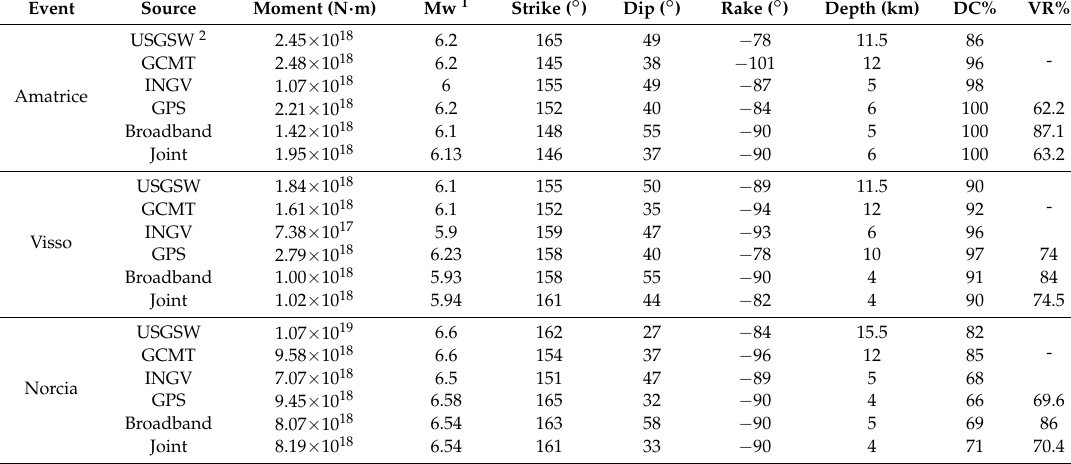
Table 3. Source parameters of the three events using different types of data compared with published results